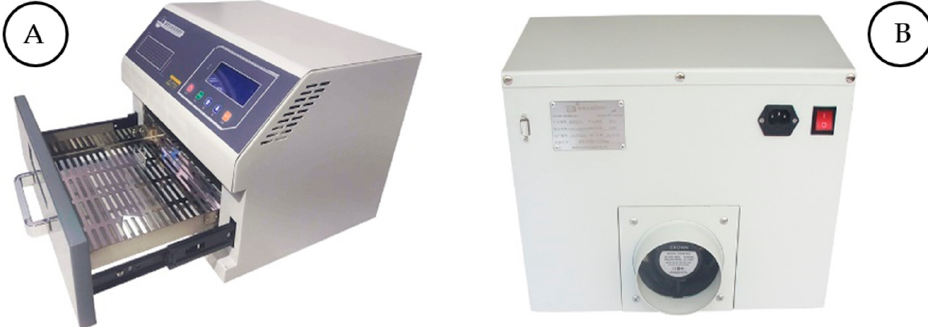
Figure 2. A ZB Series “Drawer type” reflow oven. Isometric ( A ) and back ( B ) views respectively.